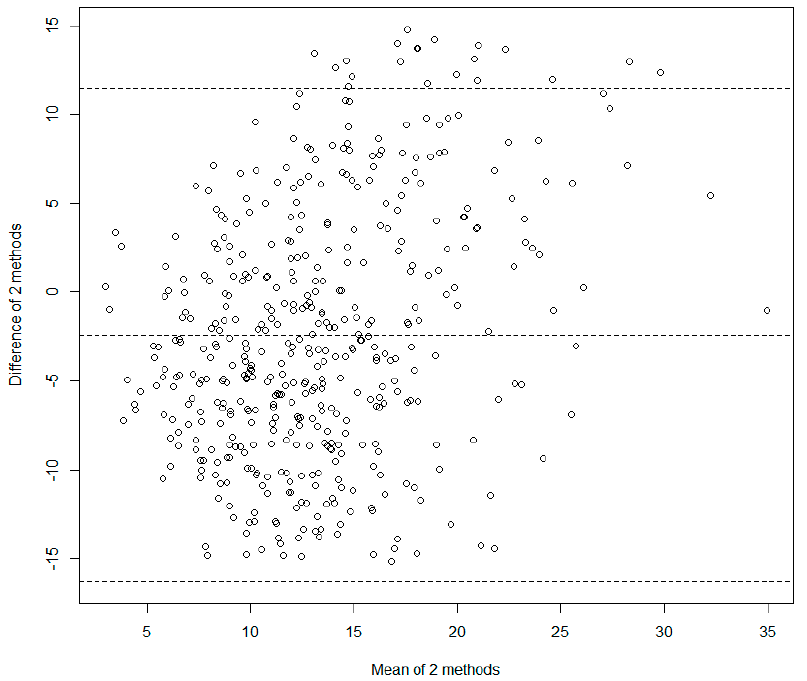
Figure 2. The Bland-Altman plot.